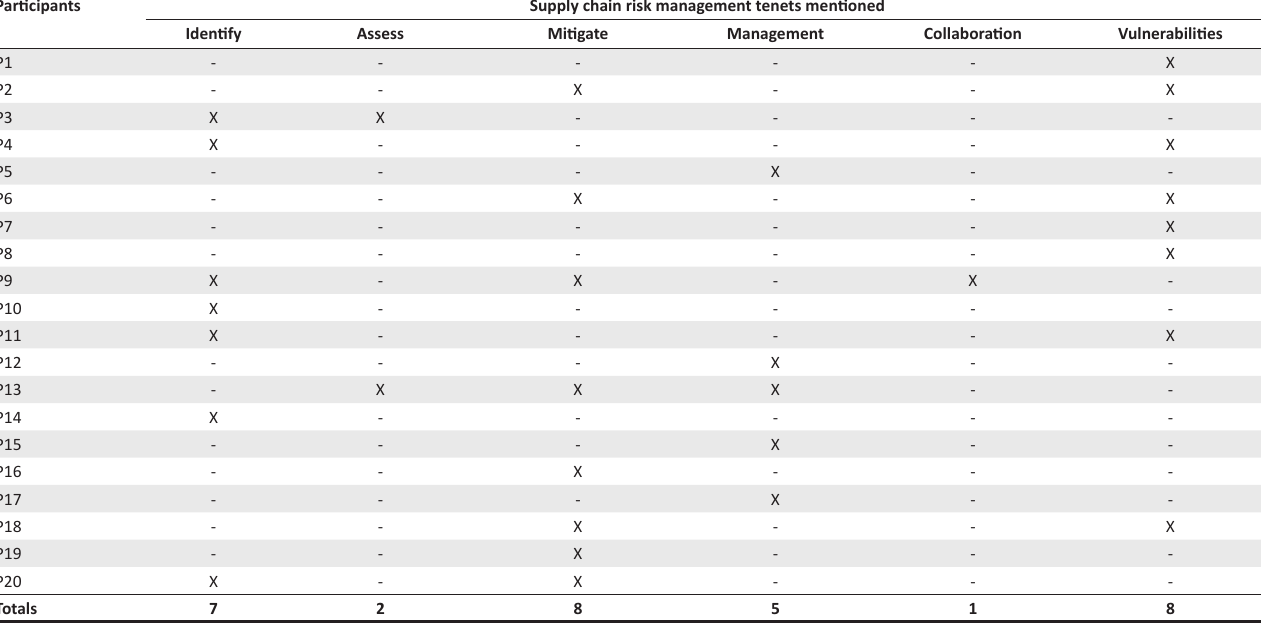
FIGURE 2: Frequency table: Primary themes and sub-themes. TABLE 2: Frequency table of supply chain risk management